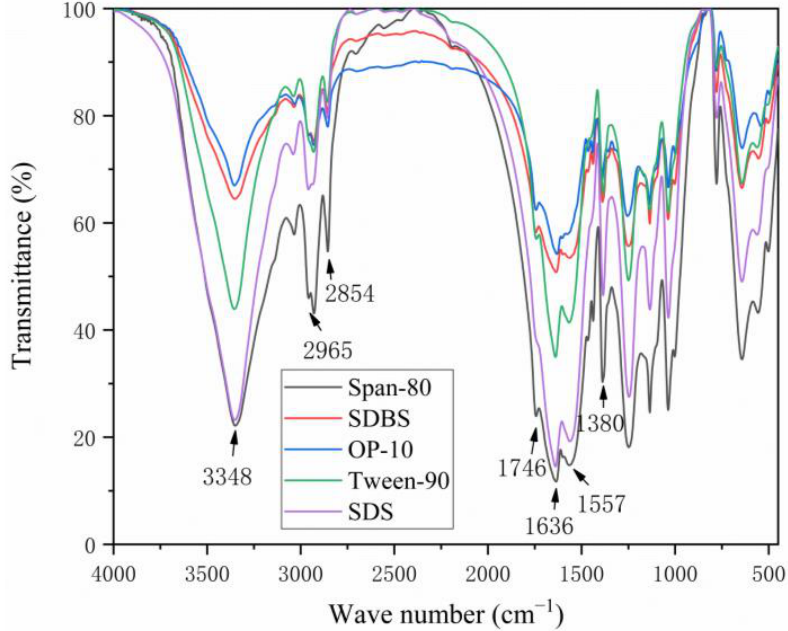
Figure 4. Infrared spectra of five emulsifier microcapsules.